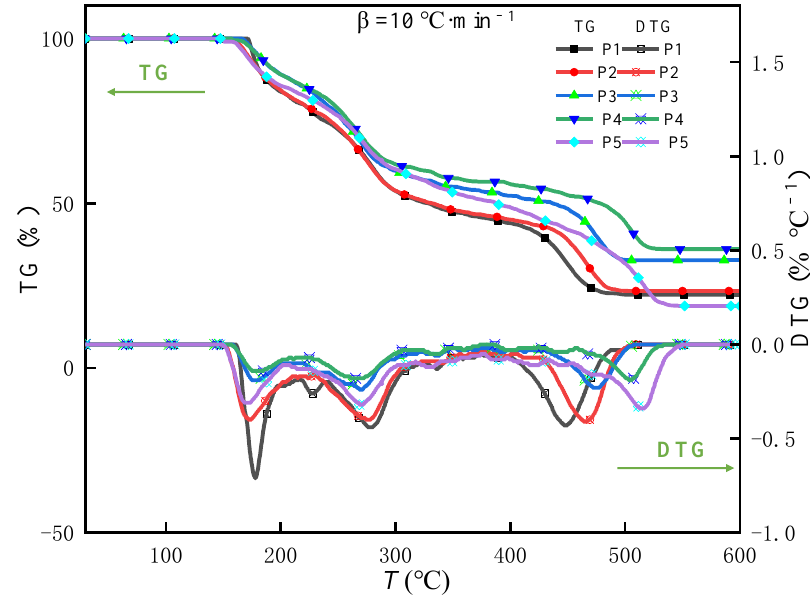
Figure 10. The TG-DTG curve of Samples P1 – P5 at β = 10 °C·min − 1 .